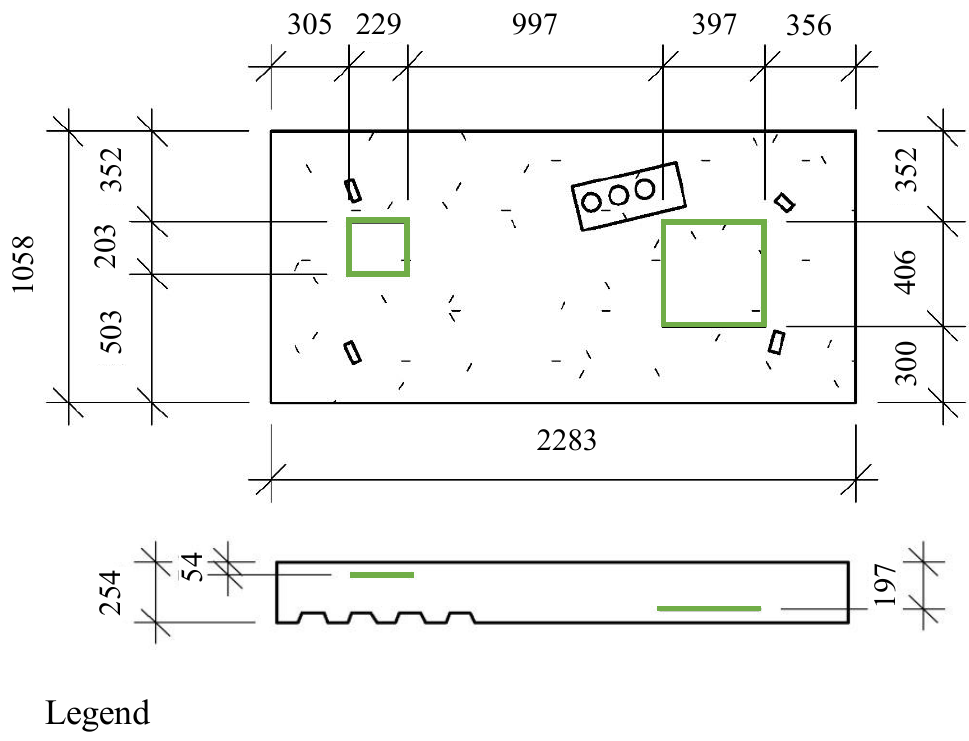
Figure 4. Slab dimensions.